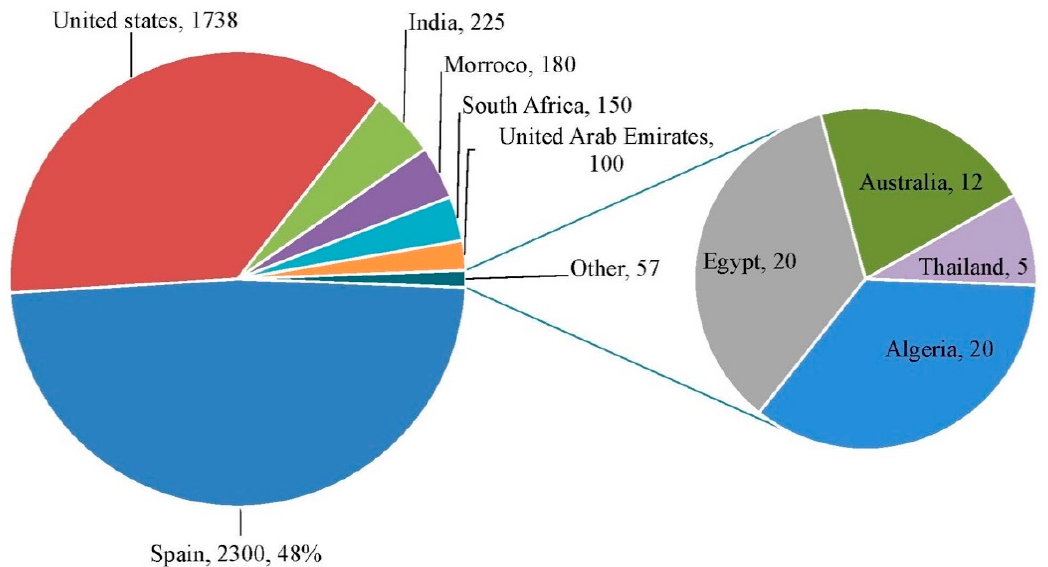
Figure 1. Status of concentrated solar power (CSP) plants worldwide.